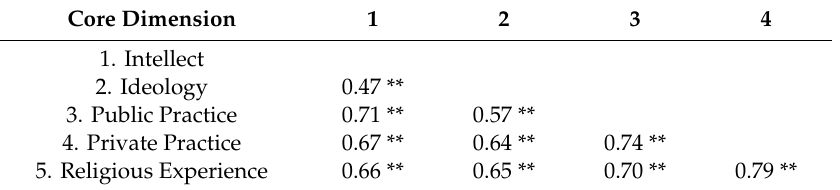
Table 6. Correlation Matrix of CRSi-20 Subscales.